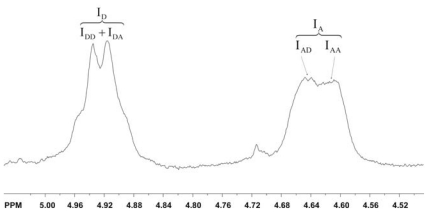
Section of the anomeric region of the 1H NMR spectrum of chitosan; DA = 48. Spectrum was recorded at 400 MHz and 80 °C in D2O (pD ~ 5) relative to internal acetone (δH 2.225). Appropriate intensities of sequences are labeled.